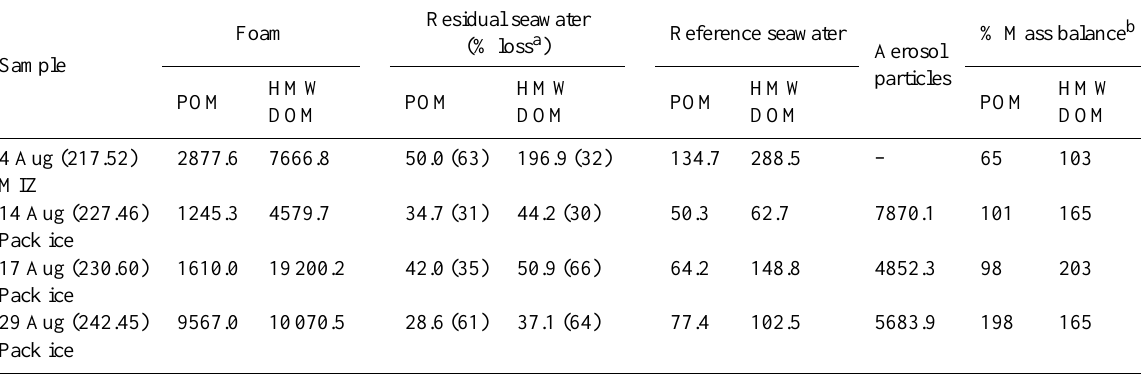
Table 6. Total hydrolysable neutral sugars (THNS) concentration (nM) in the particulate (POM) and high molecular weight dissolved (HMW DOM) organic matter fractions of foam and aerosol particles generated by bubbling experiment as well as the residual, bubbled seawater. Also shown for comparison are concentrations in unsparged seawater (reference).